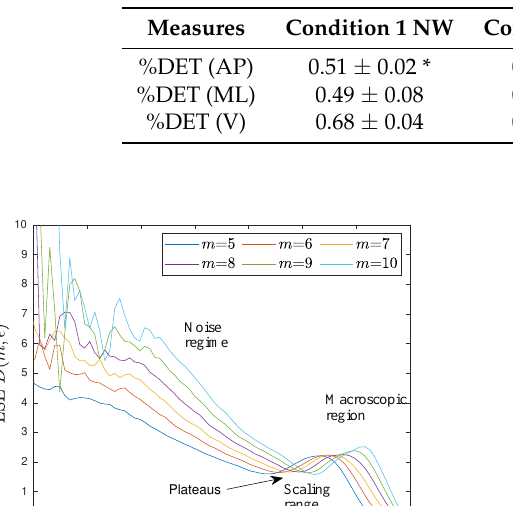
Table 2. %DETs for the acceleration data of all the subjects in three directions. Values are reported as median ± median absolute deviation; * indicates a statistically significant difference in the %DET between conditions 1 and 3.